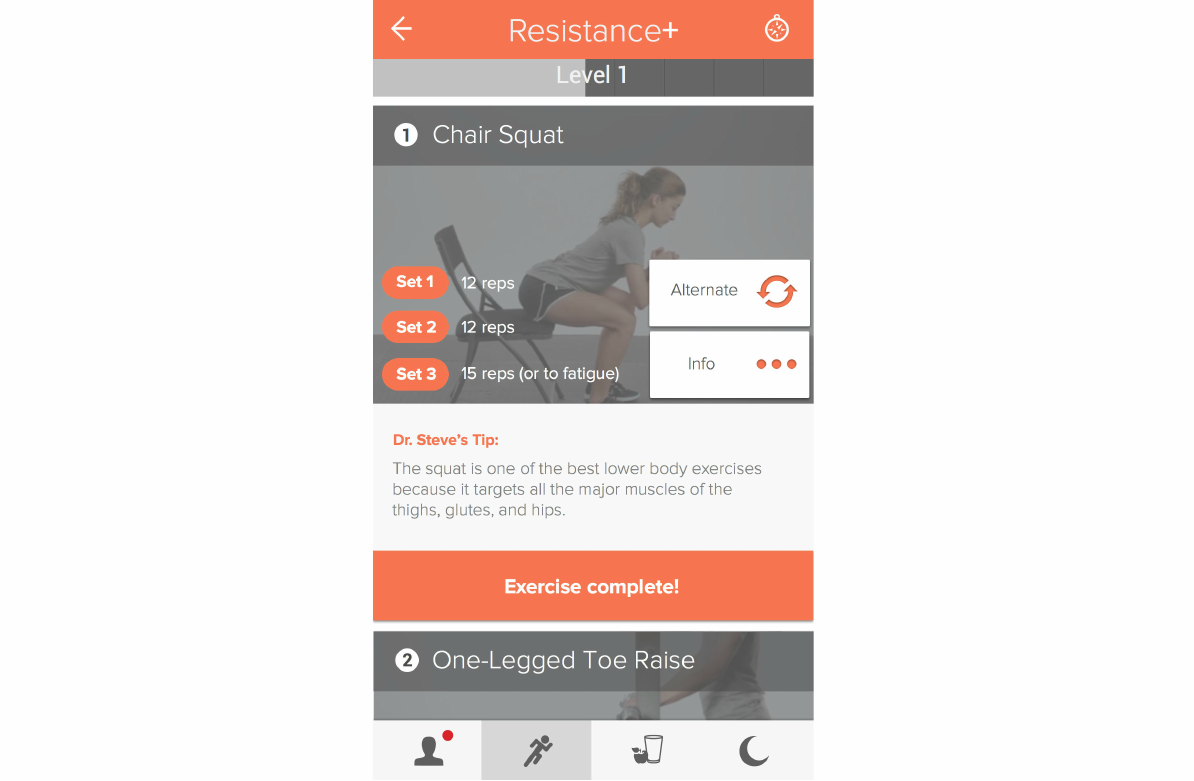
Figure 2. Sample exercise guidance